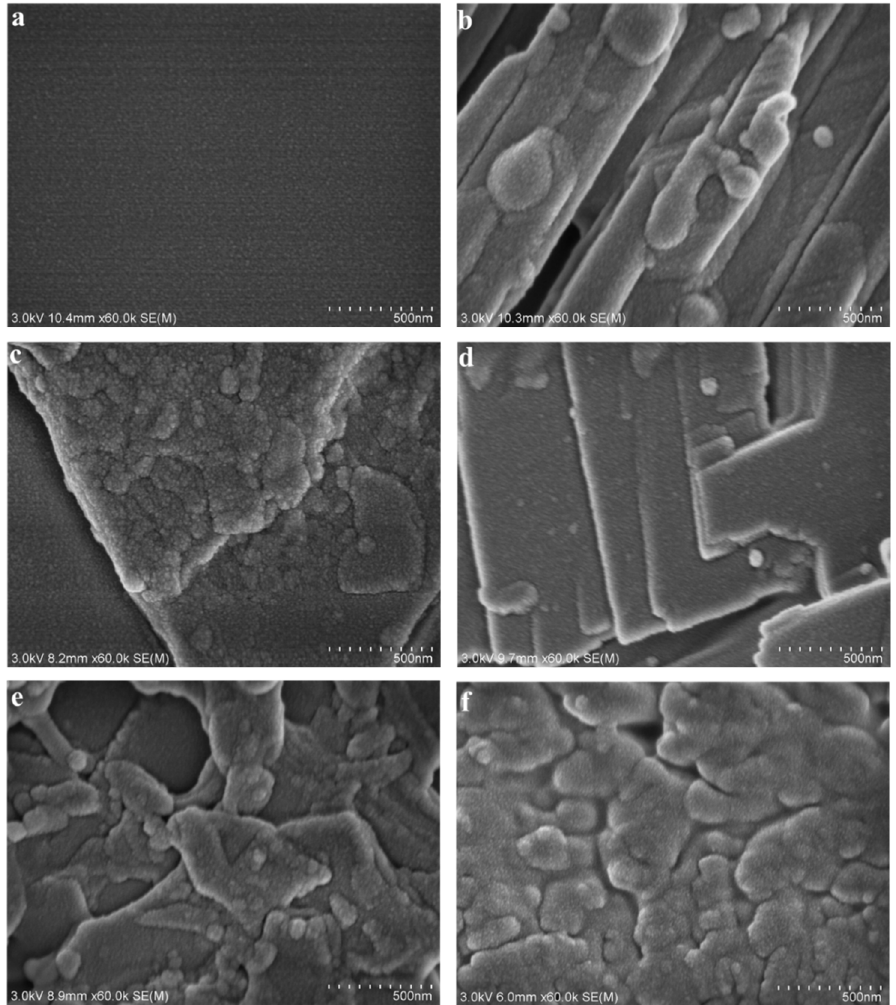
Figure 12. SEM images of ( a ) unmodified oil-wet calcite and of oil-wet calcite modified with ( b ) CTAB, ( c ) SDS, ( d ) TX-100, ( e ) rhamnolipid, and ( f ) sophorolipid. AFM images of the oil-wet calcite surface treated by five surfactants are shown in Figure 13. CTAB, SDS, TX-100, rhamnolipid, and sophorolipid treatments led to different oil- wet calcite surface topographies and roughness values. The oil-wet calcite surface became more hydrophilic when the surface roughness became higher in a certain range